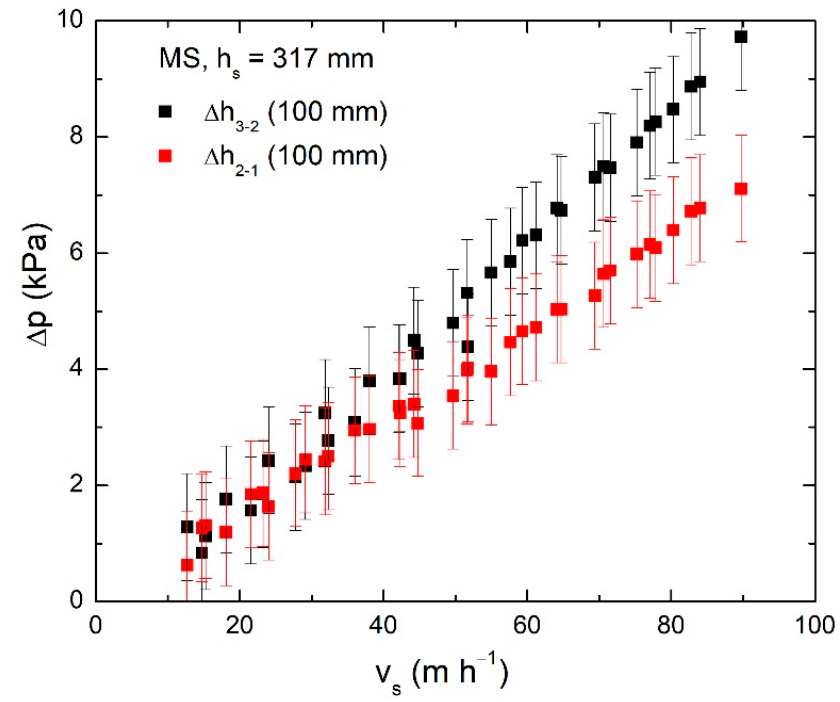
Figure 14. Experimental data of pressure drop in the granular bed at slab located between h 3 = 300 mm and h 2 = 200 mm ( ∆ h 3 − 2 ) and at slab located between h 2 = 200 mm and h 1 = 100 mm ( ∆ h 2 − 1 ). Microspheres (MS) case with h s = 317 mm.